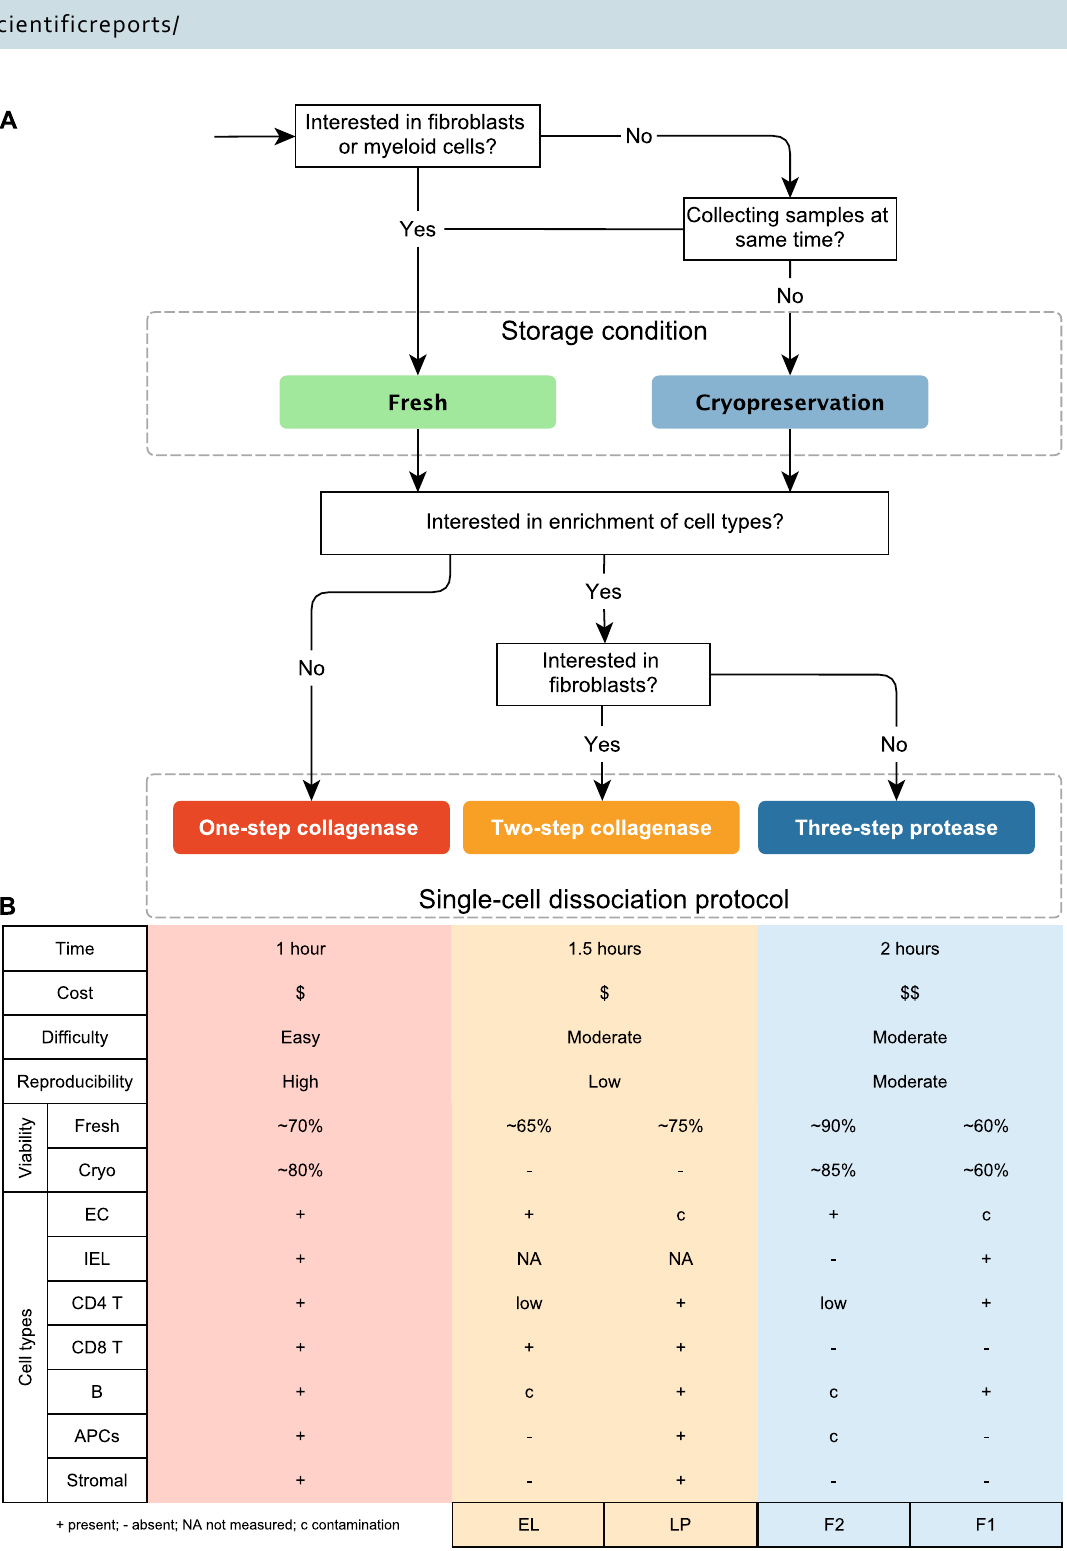
By propagating epithelial and immune cells using cryopreserved and dissociated cells, we showed the versa- tility of the one-step protocol for use in other experiments than scRNA-seq. We believe that multiple layers of